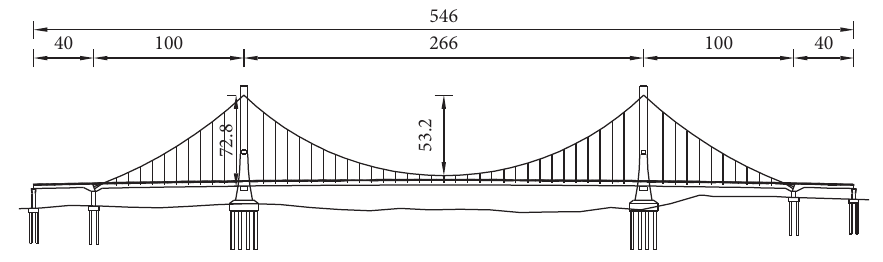
Figure 1: Overall layout of bridge A (dimensions are in